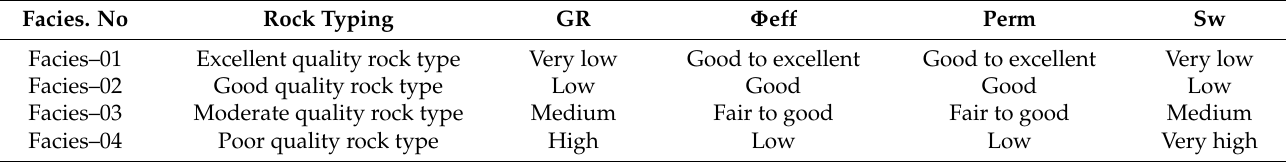
Table 5. The properties of log